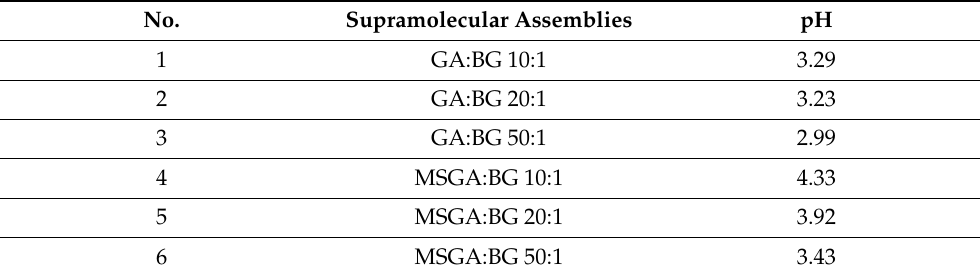
Table 1. pH of as-prepared 0.1 wt.%